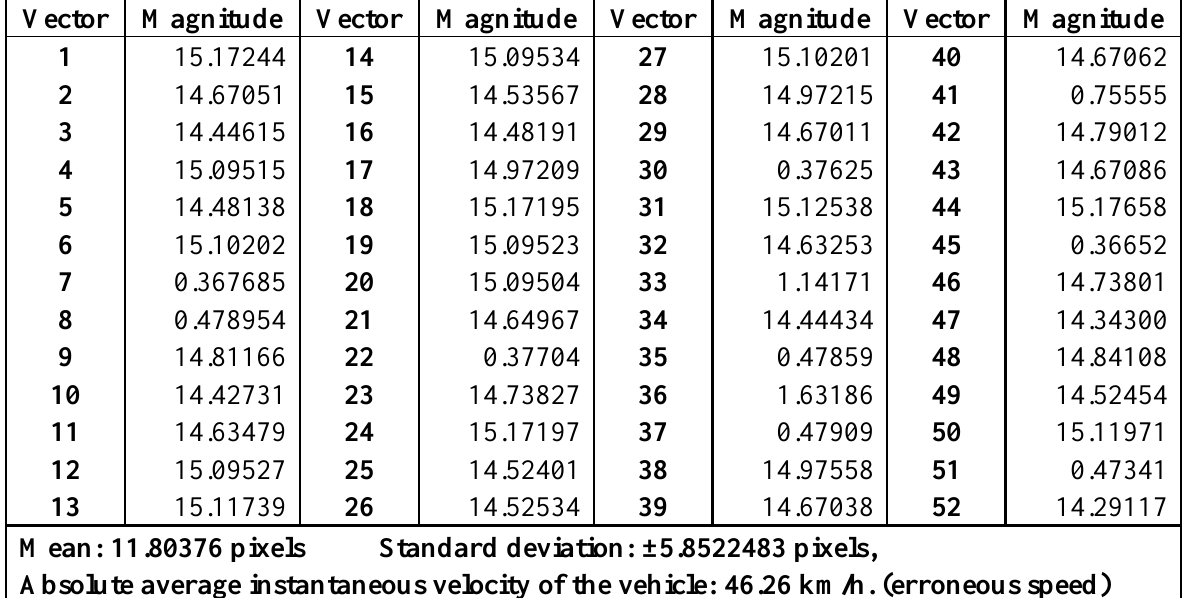
Table 4. Magnitudes of all vectors in